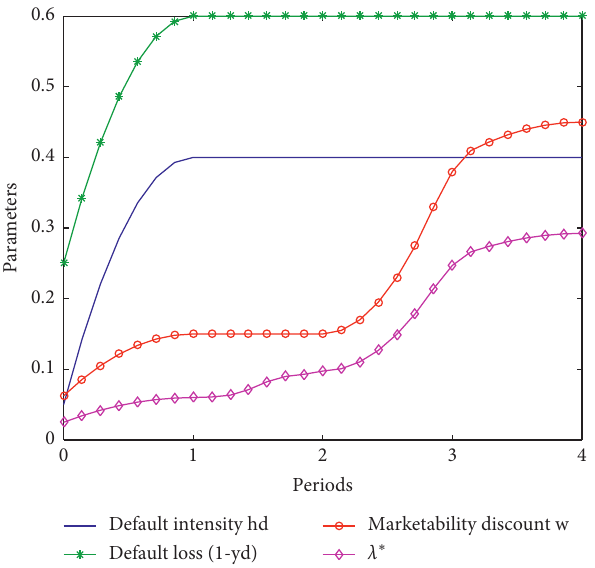
Figure 2: Parameter settings for credit-leading crisis.